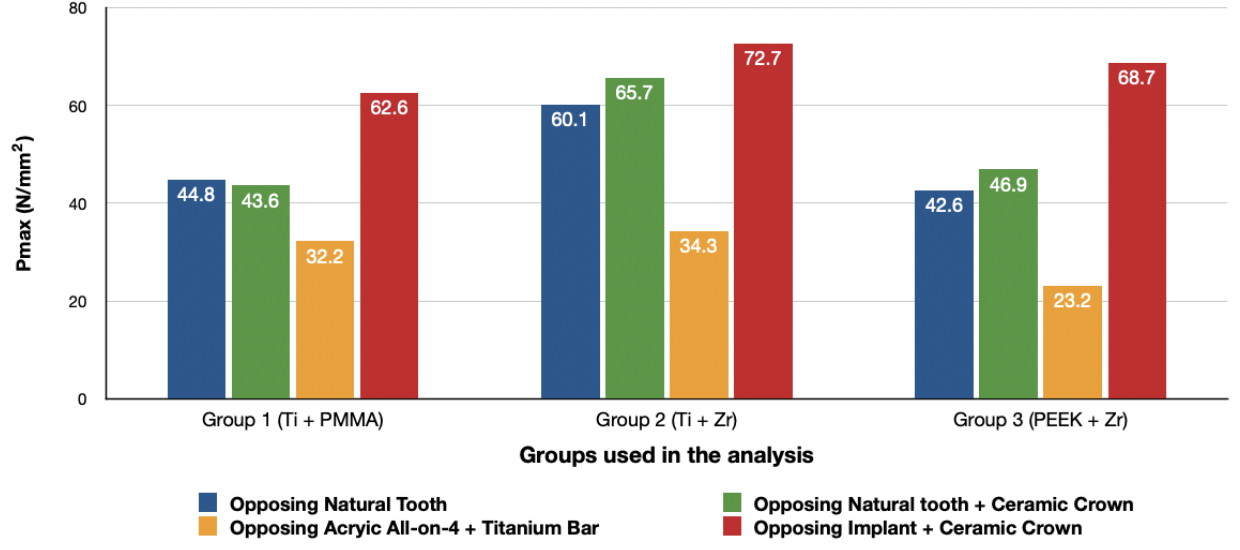
Figure 4. Maximum principal stresses (N/mm 2 ) on cortical bone.